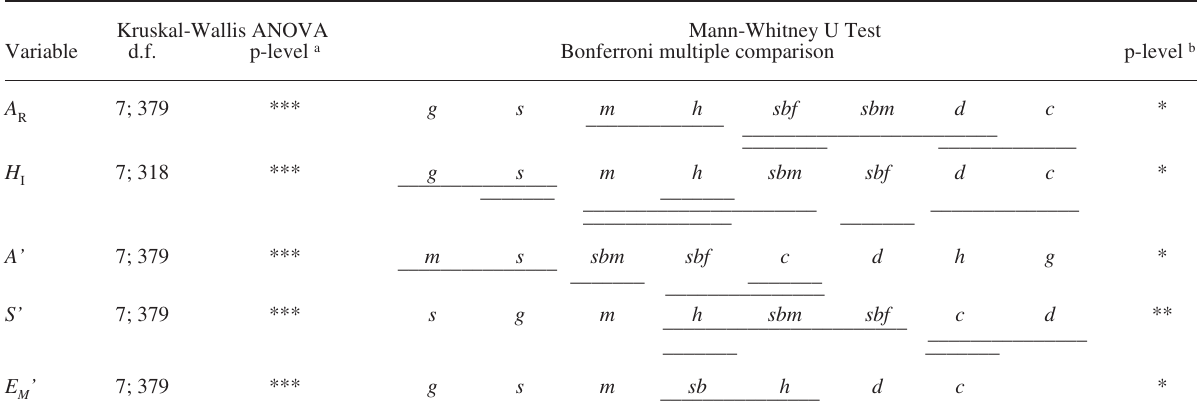
), hepa- r ’ ) among Galeus m